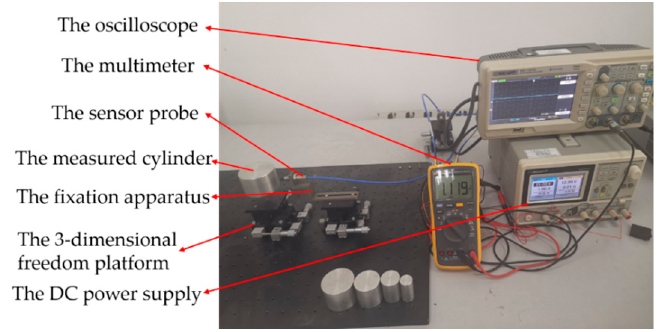
Figure 14. The eccentric experimental platform.